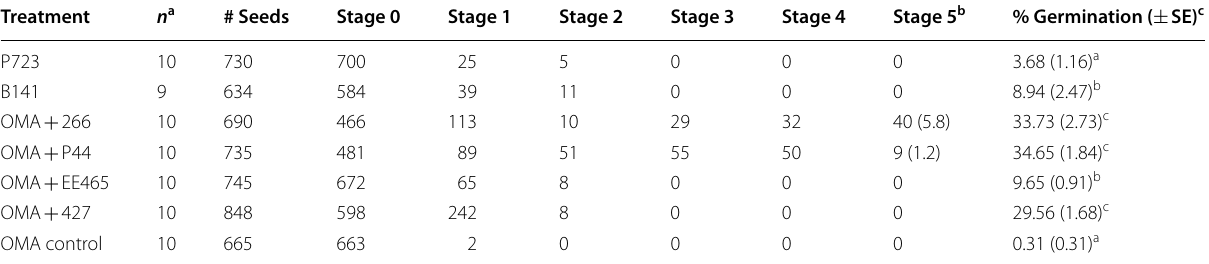
Note that Tulasnella calospora 266 facilitated the largest percentage of seedlings (> 5.8%) to the highest growth stage for all treatments including the three symbiotic treatments that utilized fungi isolated more recently (2016 and